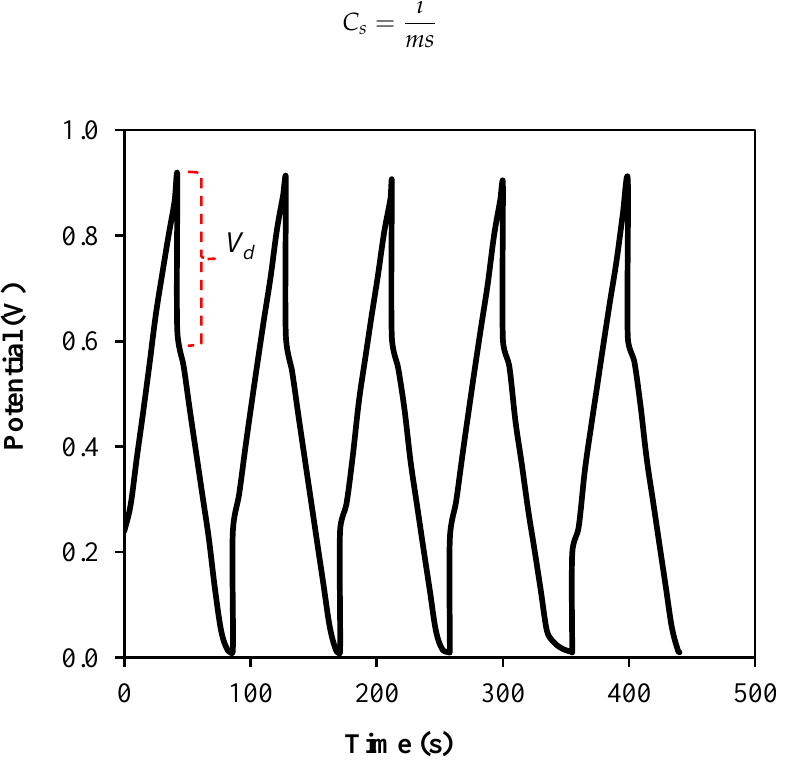
Figure 10. Charge–discharge curves at the selected cycles.